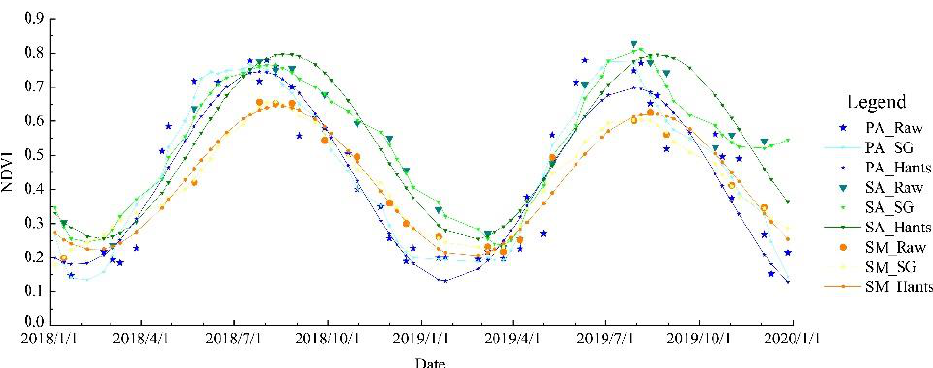
ized difference vegetation index (NDVI) of ( a ) P . australis , ( b ) S . alterniflora and ( c ) S . mariqueter .